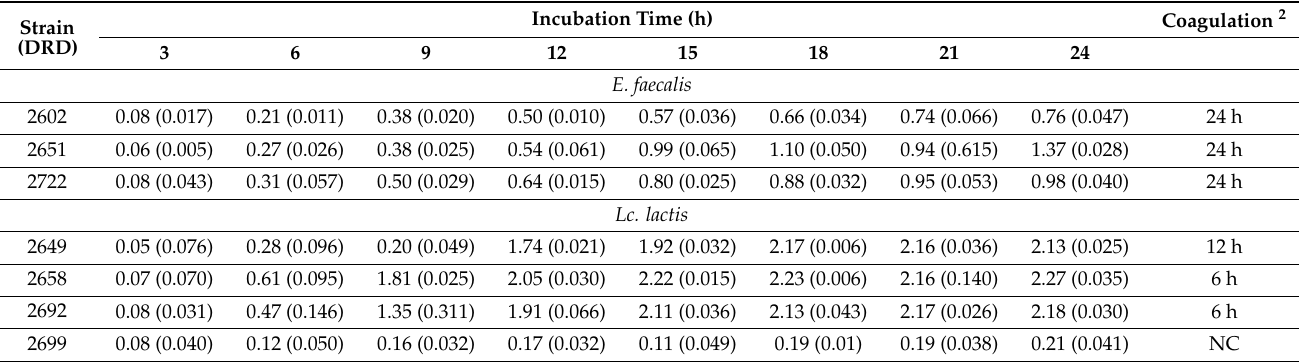
Table 1. Skim milk acidification (in ∆ pH 1 ) and coagulation capacity of representative strains of the LAB included in the present